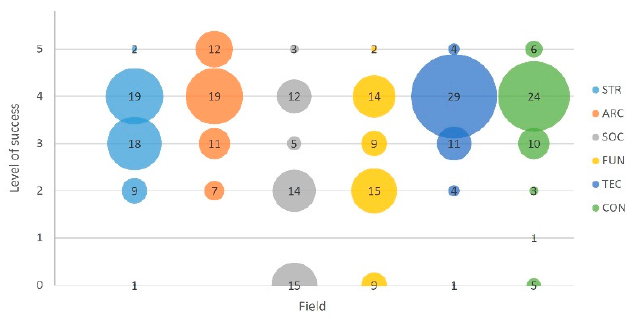
Figure 5. Levels of success for the different fields of action.